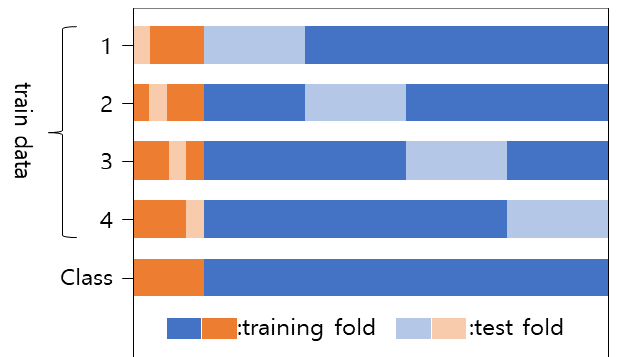
Figure 15. Structure of the GRU model in this paper. The number of units in the GRU layer is 128.